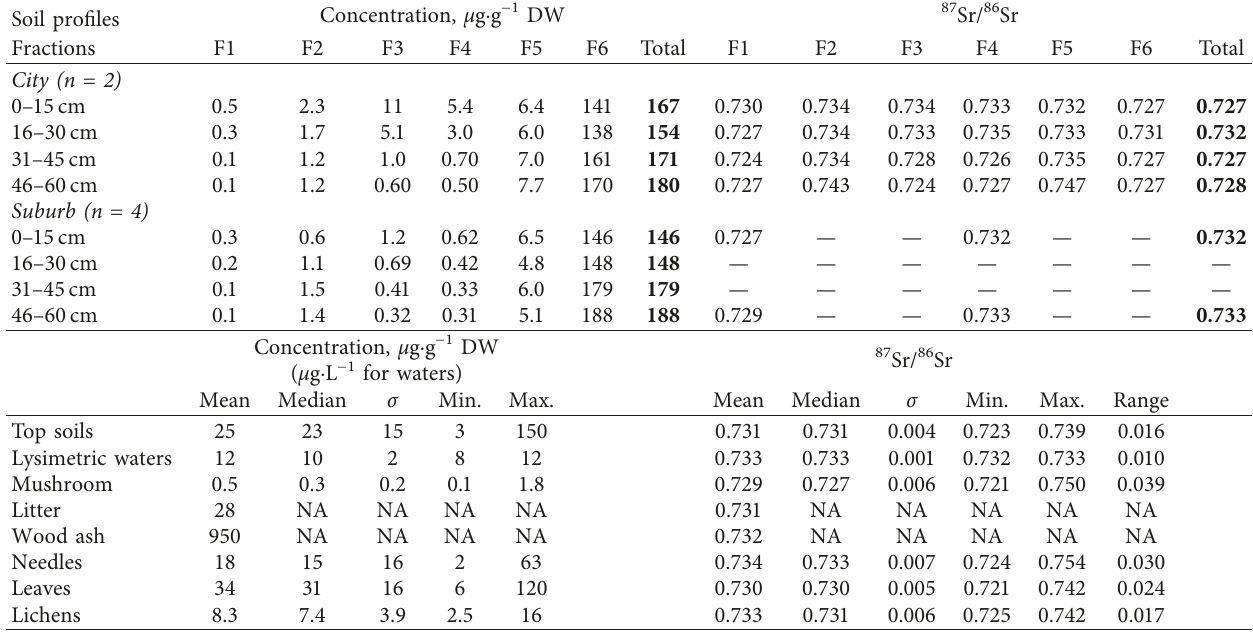
Table 10: Strontium concentrations and isotopic composition in environmental samples from Lule˚a.